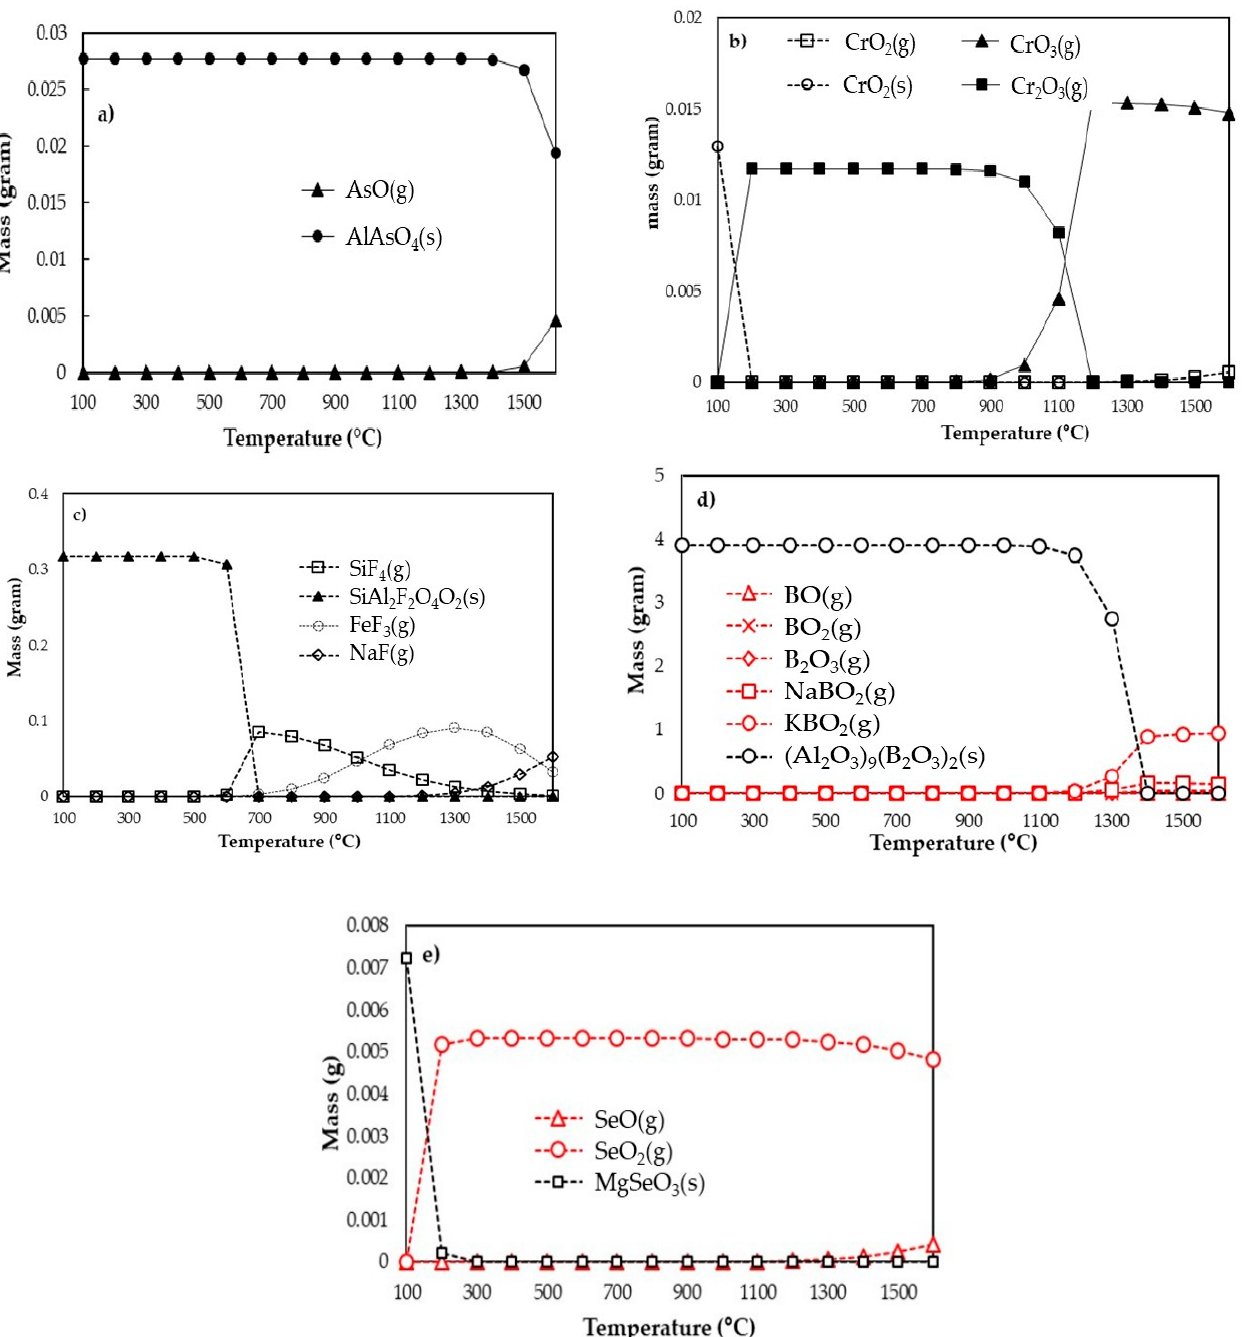
Table 4. Prediction of the species during the interaction of trace elements with CFA during the combustion process . Interaction